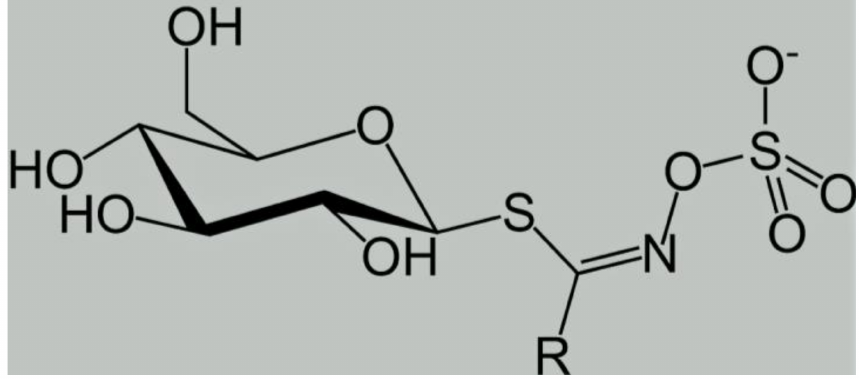
Figure 2. Molecular structure of glucosinolate compounds. R refers to the aglycone moiety (Table